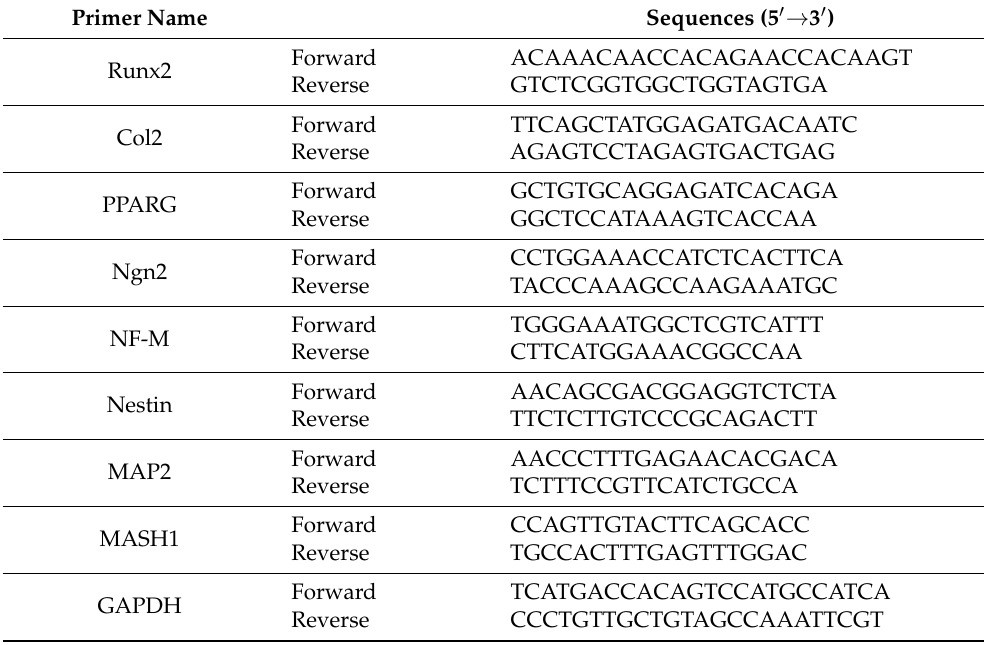
Table 1. Primers with corresponding sequences used in the